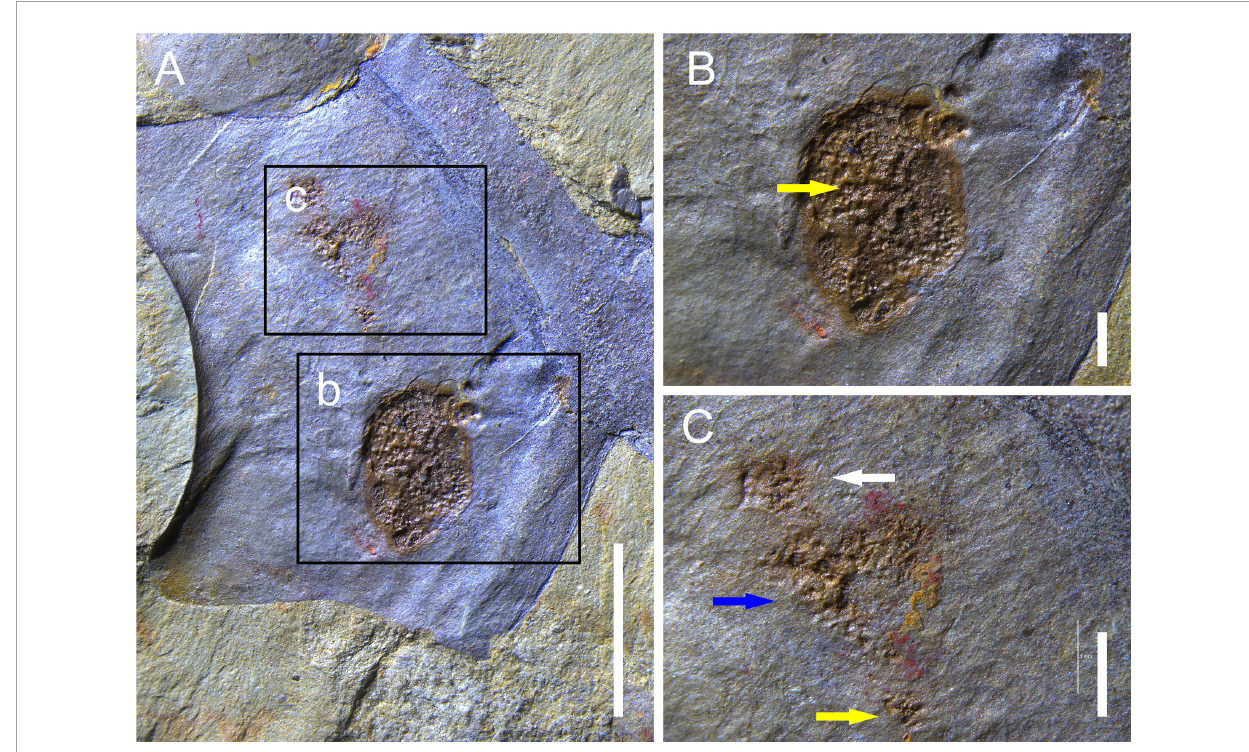
FIGURE4 The unnamed bryozoan-like metazoan (RCP-ZJ-0005-0008). (A) RCP-ZJ-0005-0008 are preserved on a trilobite librigenal; (B) detail of RCP-ZJ-0005 [position marked by frame b in panel (A) ], yellow arrow indicates an opening of the specimen; (C) detail of RCP-ZJ-0006-0008 [position marked by frame c in panel (A) ], white arrow indicates RCP-ZJ-0006; blue arrow indicates RCP-ZJ-0007 and yellow arrow indicates RCP-ZJ-0008. The scale bars are 5 mm for panel (A) and 1 mm for panels (B,C) .